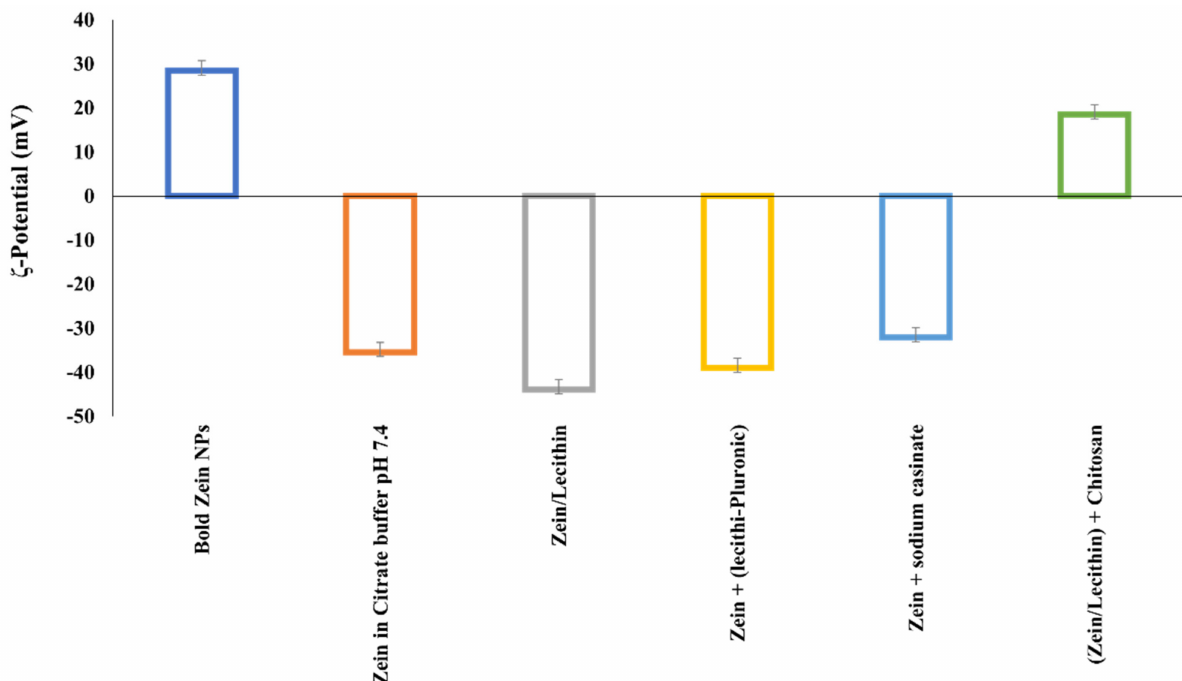
Figure 4. Change in zein surface potential by changing the dispersion